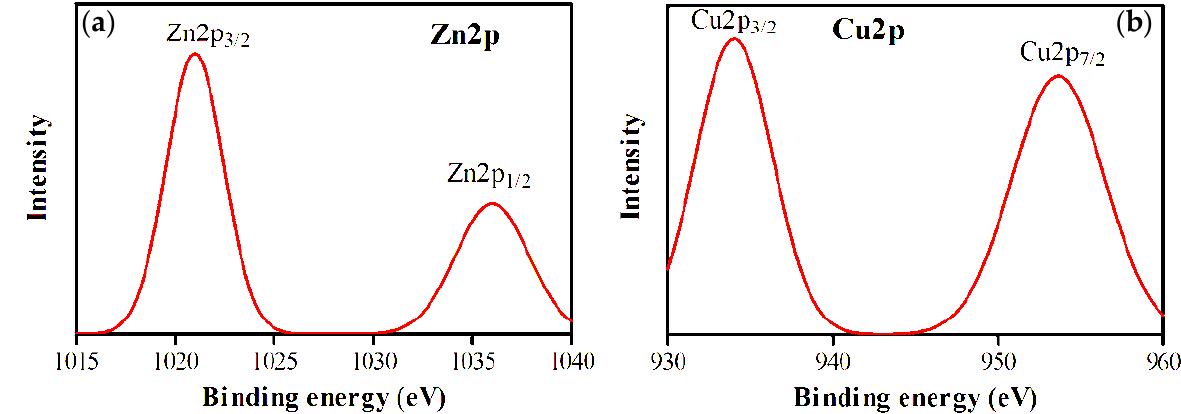
Figure 5. XPS analysis of synthesized nanocomposites, (a) Zn-2p and (b) Cu-2p.